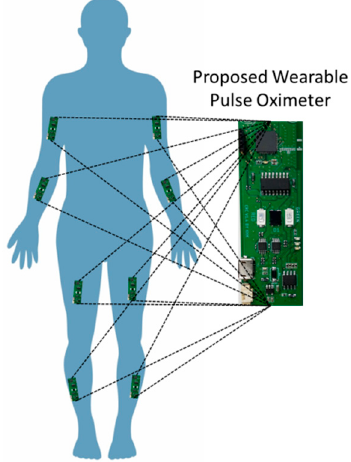
Figure 27. Possible body locations for the proposed wearable PO device.